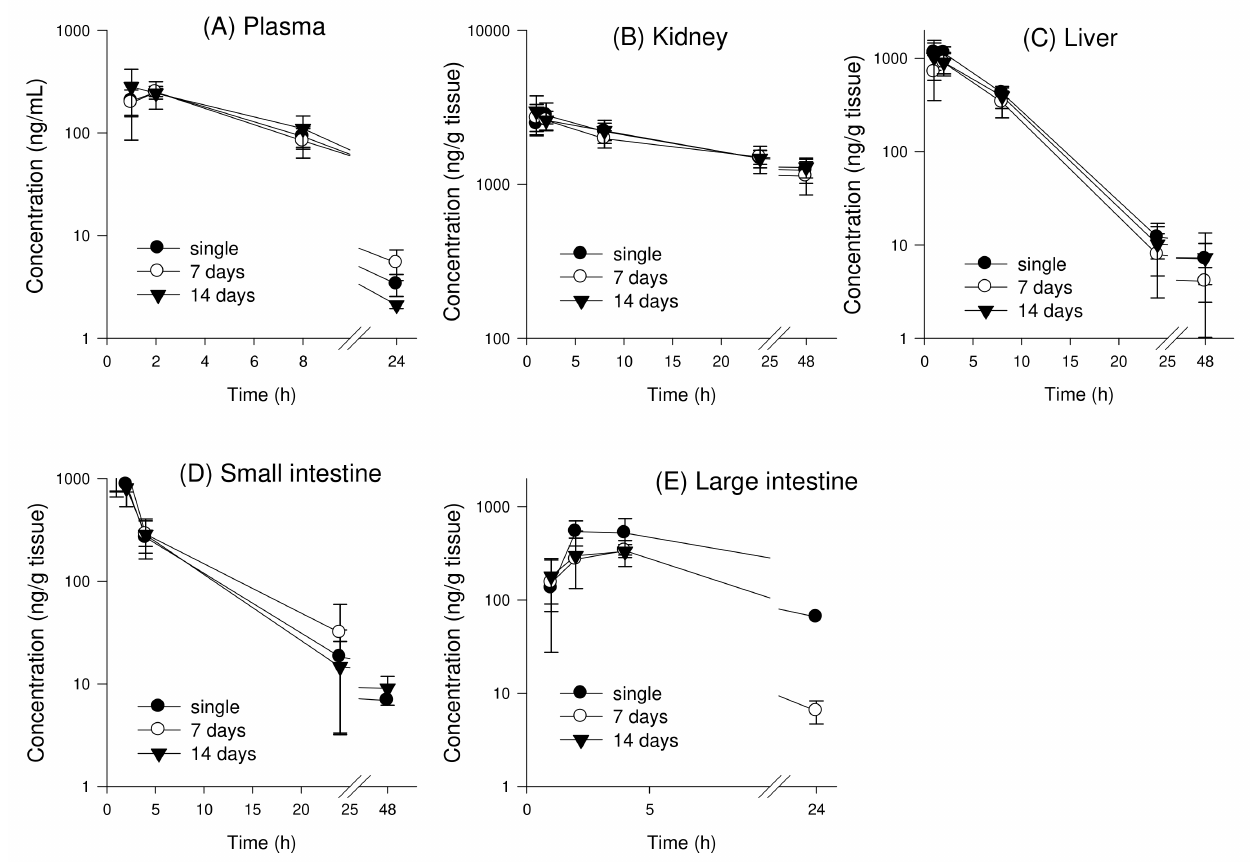
) and 14 days ( (cid:72) ). Data are (cid:35)